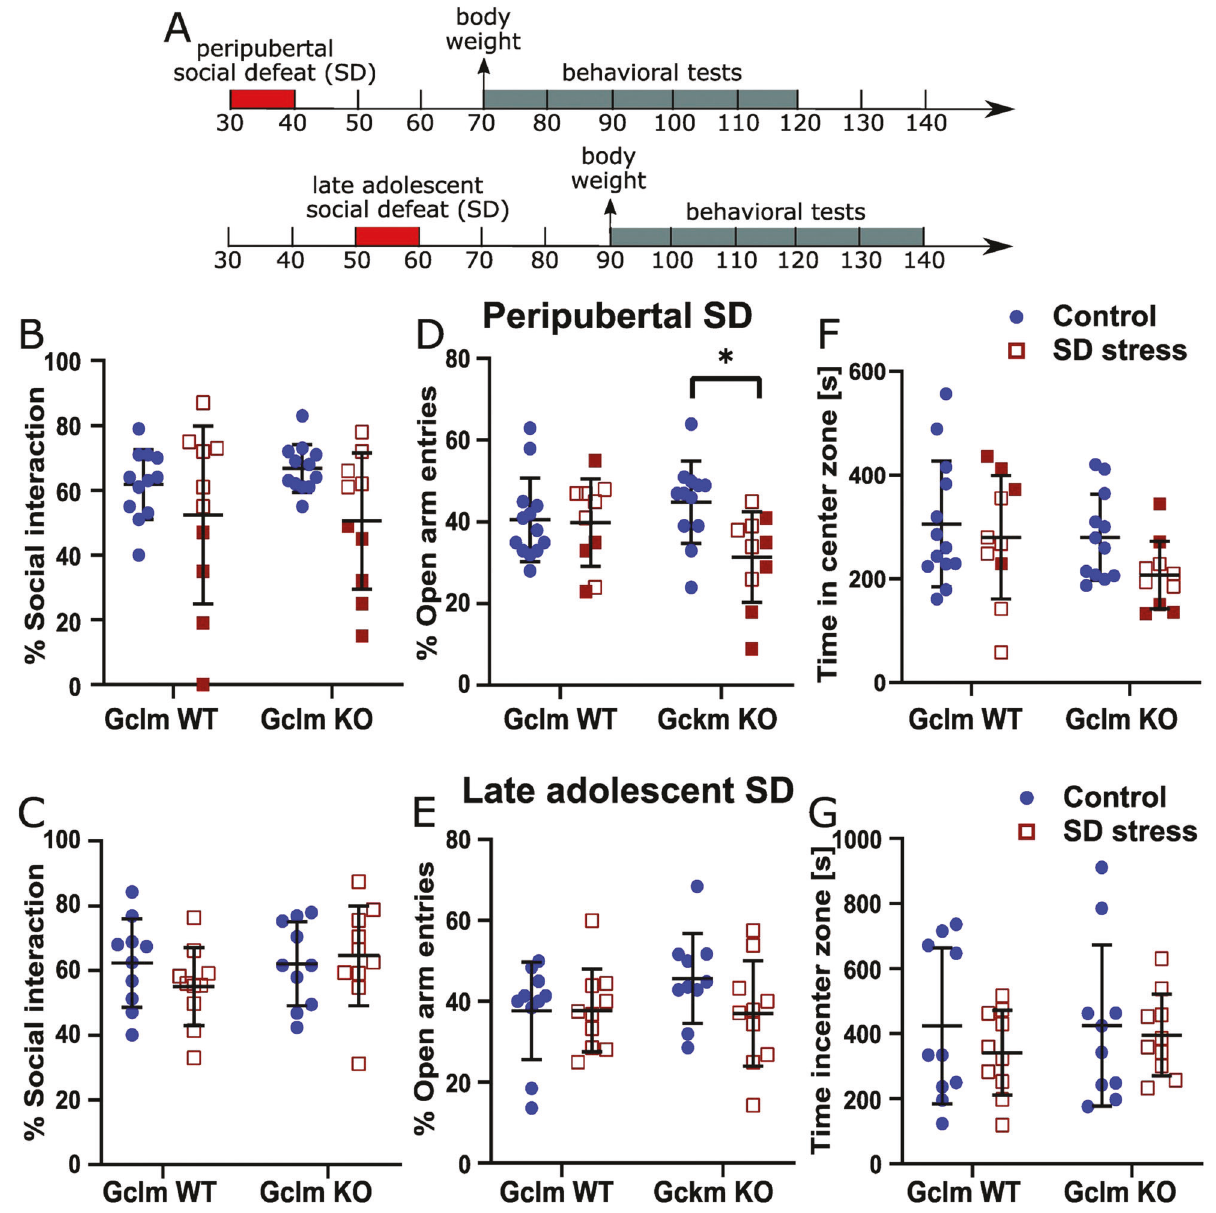
Fig. 1 Long-lasting effects of peripubertal and late adolescent social defeat (SD) stress on social interaction and anxiety-like behavior in WT and Gclm-KO mice. A Schematic diagram of the experimental design. B , C Long-lasting effect of peripubertal ( B ) and late adolescent ( C ) SD on social interaction. No stress and genotype effect in both B and C . Note a subset of mice ( fi lled squares) exposed to peripubertal SD that show strong reduction in social interactions (regardless of the genotype). D , E Long-lasting effect of peripubertal ( D ) and late adolescent ( E ) SD on open arm entries (% open arm entries relative to total entries in open and close arms) in an elevated-plus-maze (EPM). Signi fi cant peripubertal SD effect and trend for peripubertal SD × genotype interaction (in D ). F , G Long-lasting effect of peripubertal ( F ) and late adolescent ( G ) SD on the time spend in the center zone of an open fi eld. Control mice are non-stressed individuals. Data are presented with the mean and s.d. Post-hoc test: * p < the exposure to trauma or the age at the time of exposure, patients were any of the following events (physical, sexual or emotional abuse, emotional not included in the study. Over the 3-year period of treatment, case or physical neglect, bullying, migration in adversity), even during the managers completed a table containing the following information: (1) presence or absence of physical abuse, sexual abuse, emotional abuse, emotional neglect, physical neglect, migration in adversity [40], bullying, adoption, parent separation, abandon, loss of parents, (2) age at the time of fi rst exposure to these events and (3) recurrence of trauma. Here, we focused on physical/sexual abuses (PSA) as they were quite analogous to the SD used in our animal study. Patients reporting physical and/or sexual abuses were categorized according to their fi rst exposure to one of these abuses, respectively before the age of 12 (early PSA) and between 12 and 16 years old (late PSA). Non-trauma patients were those who did not report